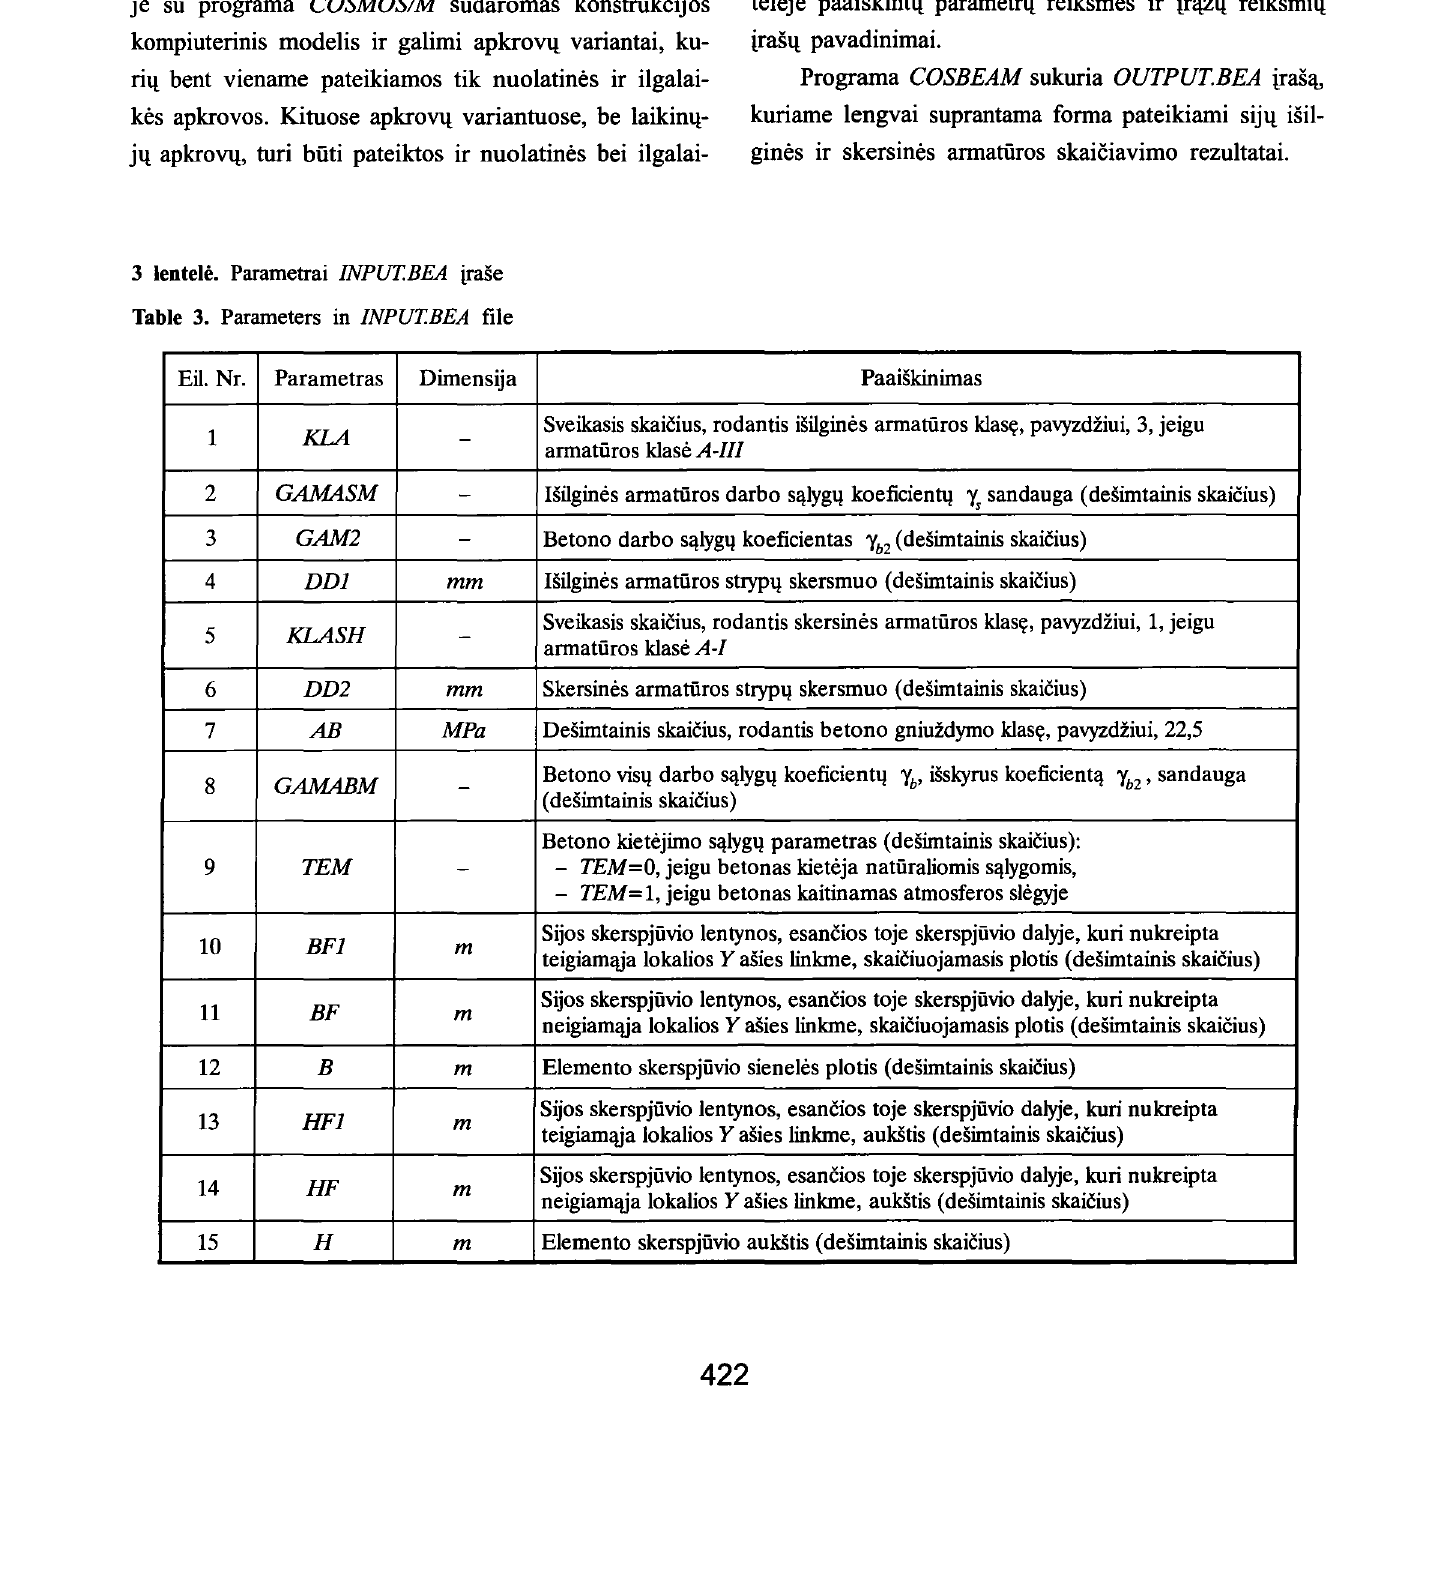
Table 3. Parameters in INPUT.BEA file Eil.